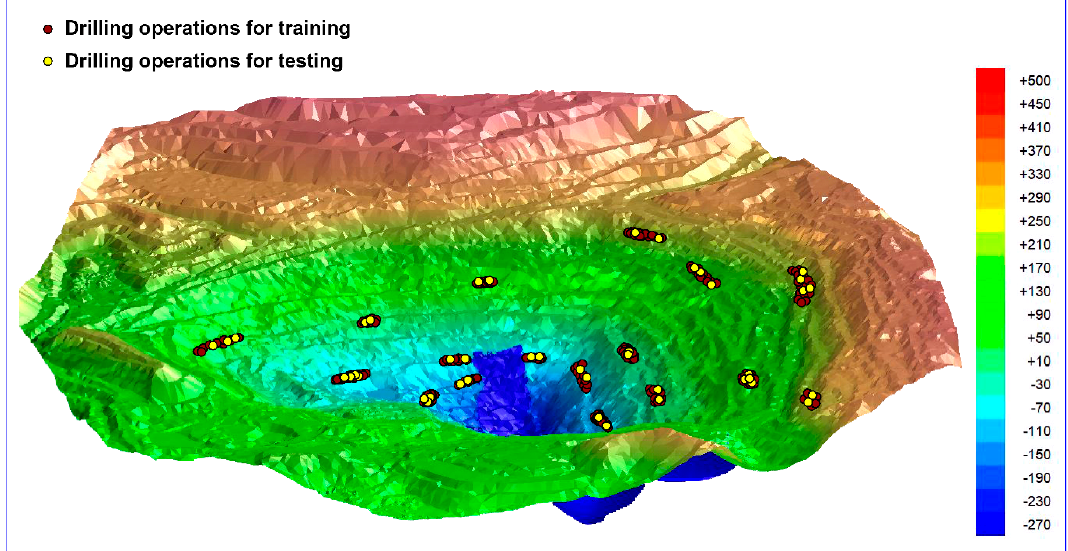
Figure 7. The database used for predicting drill-induced PM 10 concentration in this study.